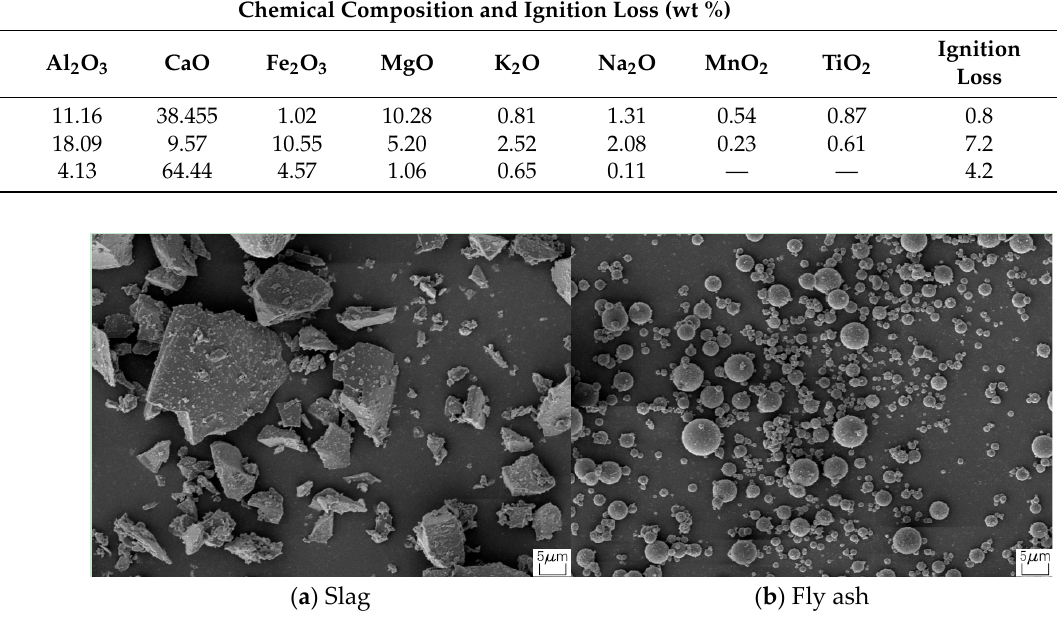
Figure 3. SEM of slag and fly ash. ( a ) Slag; ( b ) Fly ash.